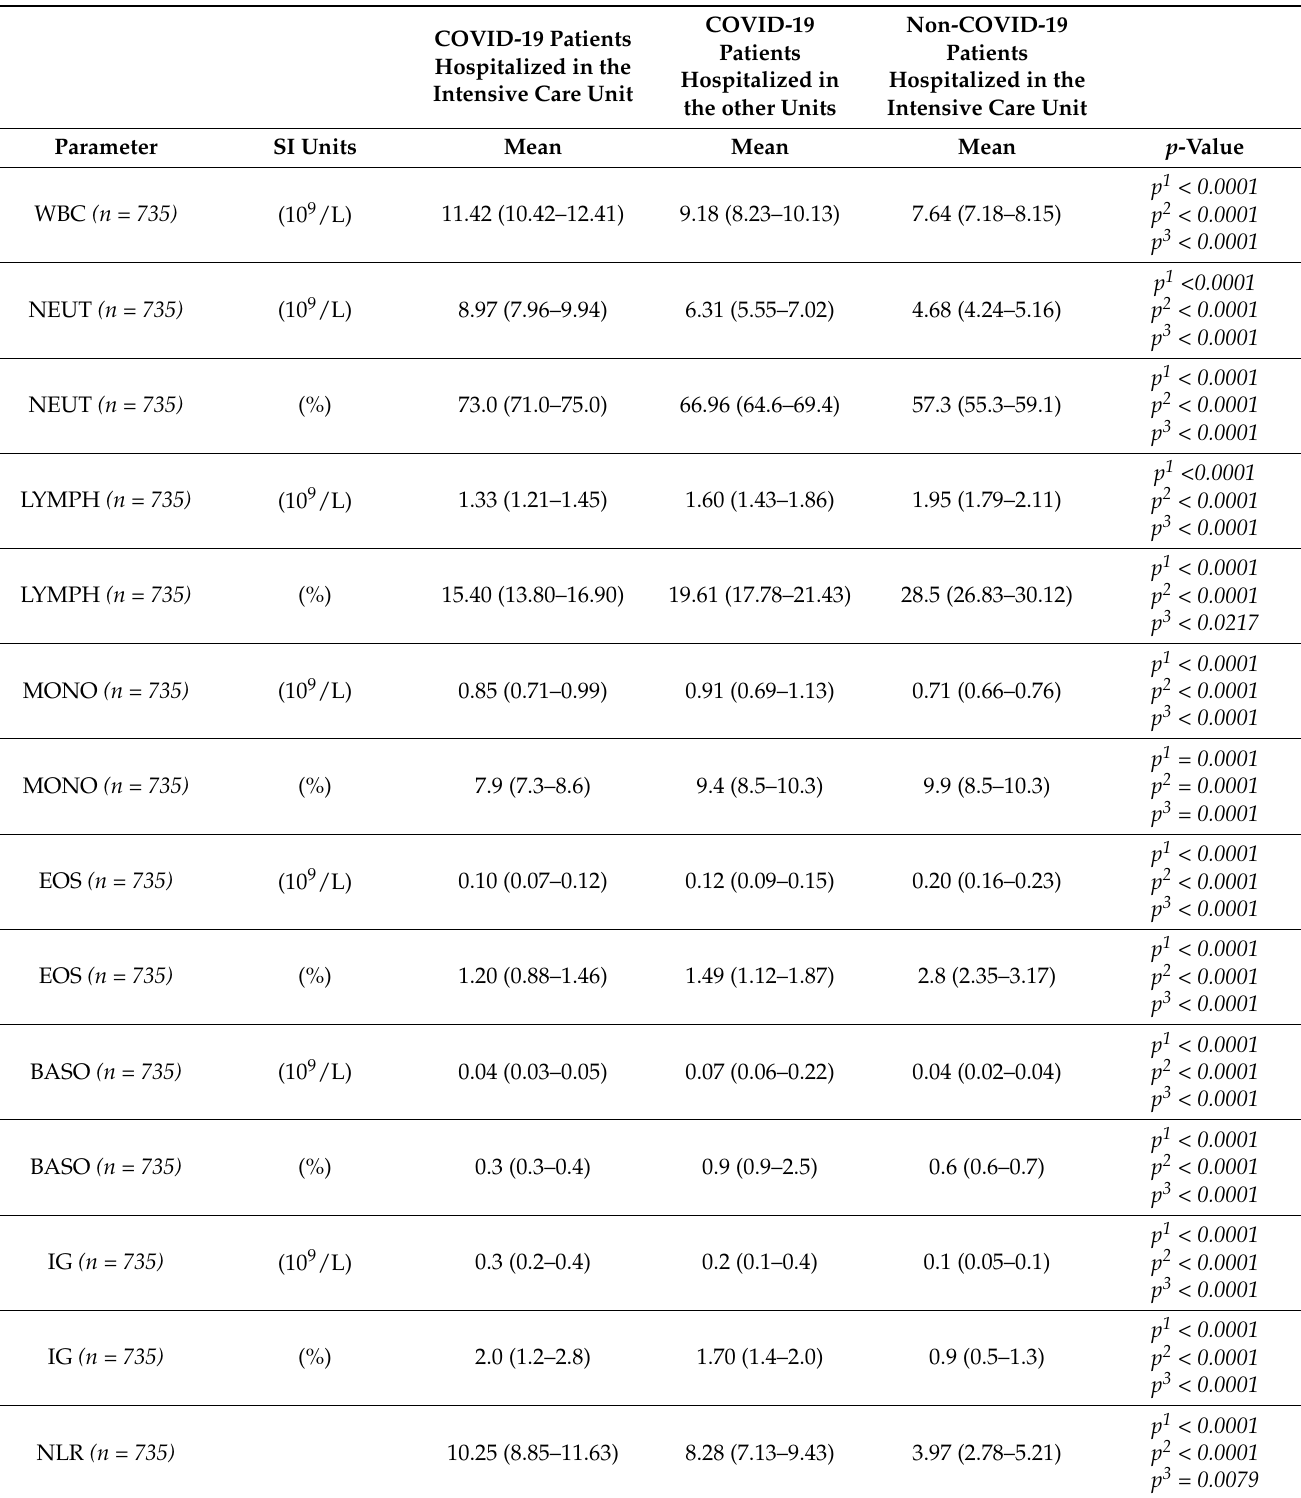
Table 1. Comparison of the results of leukocyte differentiation in patients infected with SARS-CoV-2 and noninfected ( n =